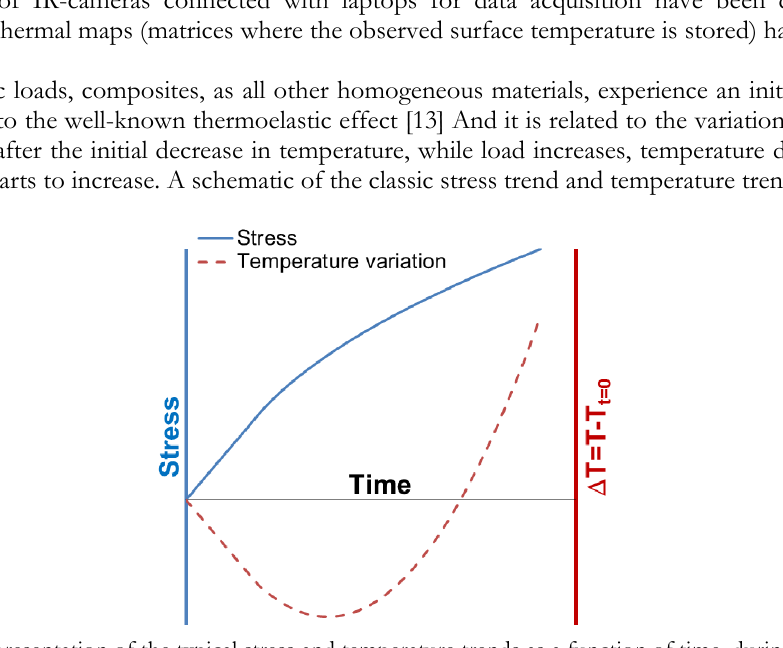
Figure 1: Schematic representation of the typical stress and temperature trends as a function of time, during a static tensile